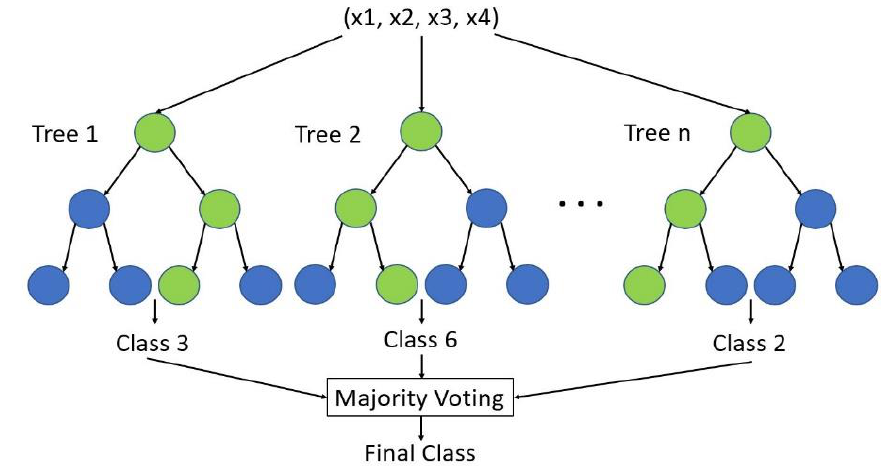
Figure 16. Random forest architecture.